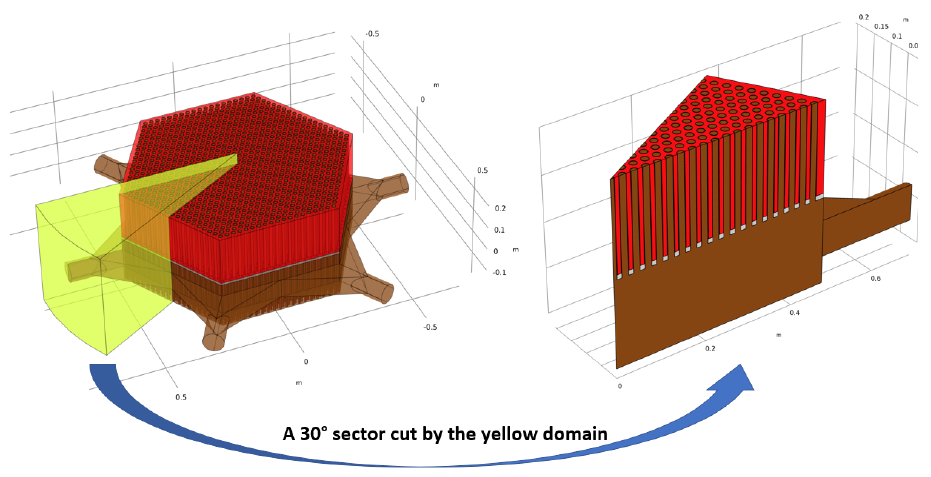
Figure 4. A 30 ◦ sector of the distribution zone and core zone with a height of 0.4 m, z = 0 m to z = 0.4